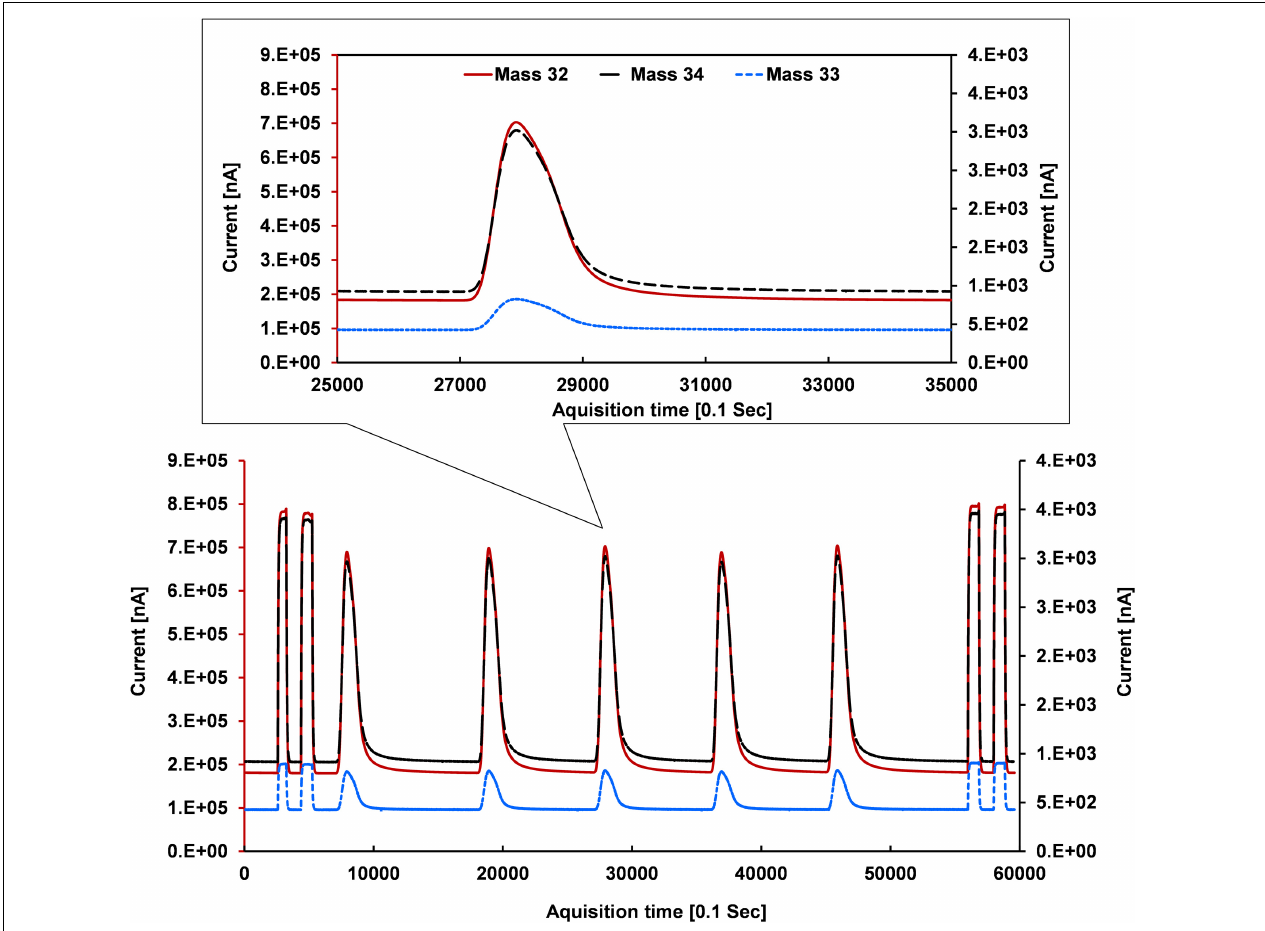
FIGURE 2 | Ion beams of mass/charge 32 (primary y -axis), 33 and 34 (secondary axis) where references appear in rectangular shapes and sample signals as Gaussian (not perfect Gaussian due to H 2 O sticking nature, upper panel sub-plot) peaks which were obtained after optimizing the reactor composition and